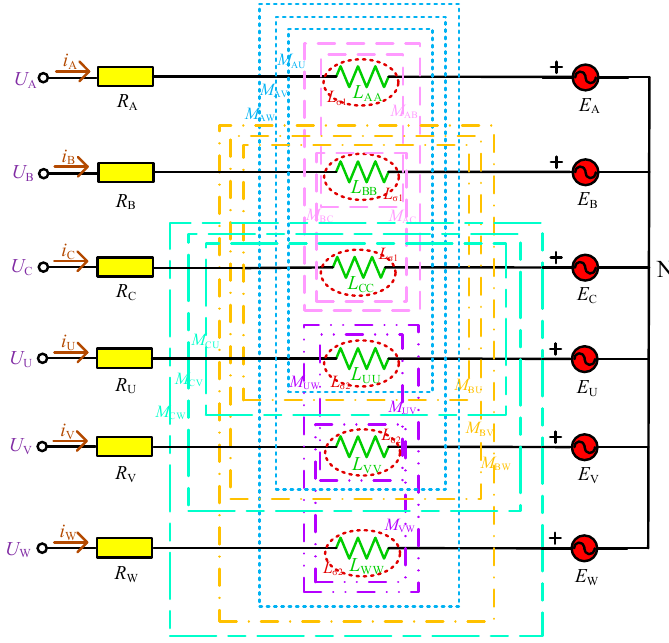
Figure 3. Equivalent circuit diagram of CSPM motor.